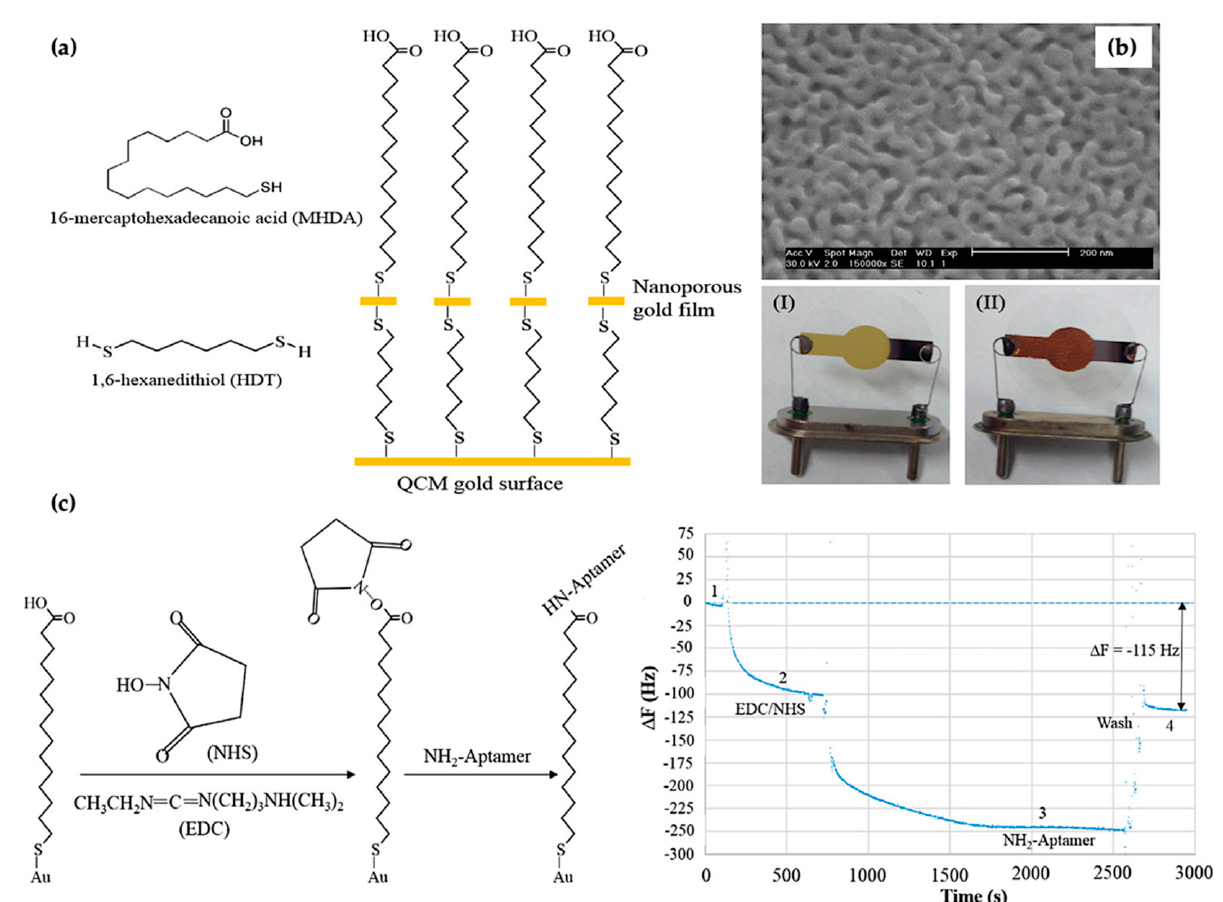
Figure 5. ( a ) Bifunctional dithiol immobilization process onto QCM gold surface; ( b ) SEM image of nanowell-based QCM electrode: (I) the bare QCM electrode and (II) the nanoporous gold film modified QCM electrode; ( c ) design process of NH 2 -aptamer immobilization and QCM aptasensor sensorgram graph: (1) the SAM generated on the sensor in equilibrium with distilled water; (2) NHS/EDC activation; (3) NH 2 -aptamer immobilization; and (4) washing to obtain the baseline. Reprinted with permission from Ref. [115] 2017, Wang.